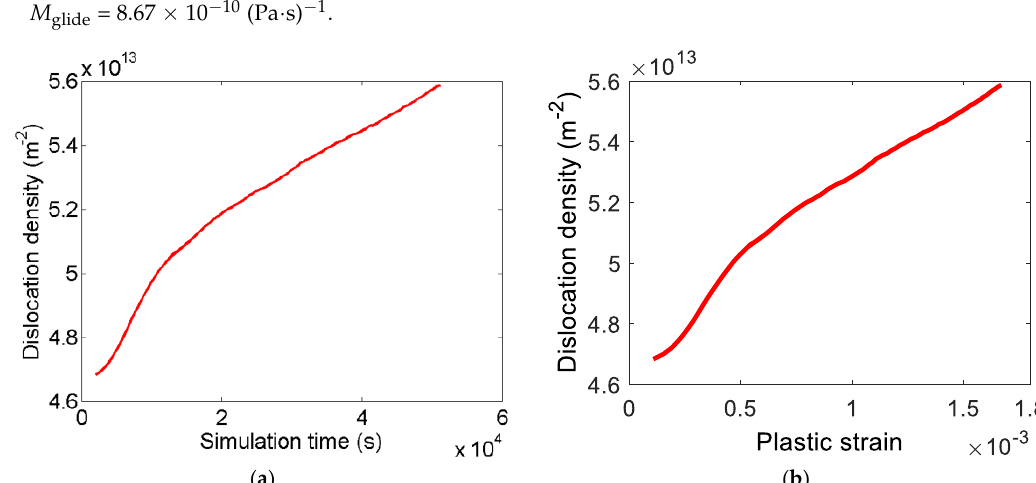
Figure 6. ( a ) Plastic strain and ( b ) plastic strain rate versus simulation time for M glide = 8.67 × 10 −10 (Pa·s) −1 .